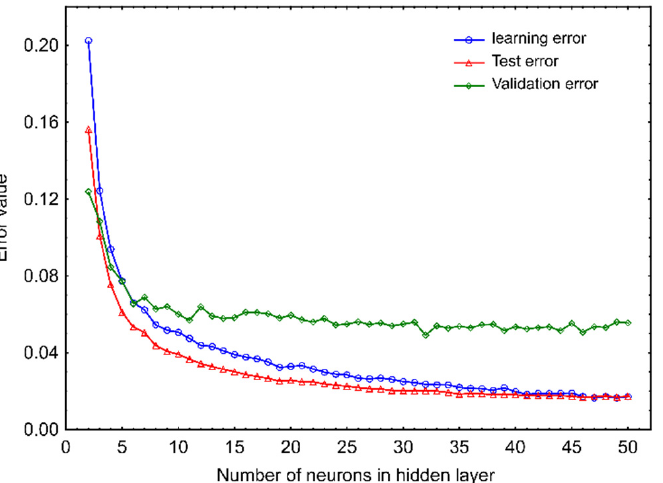
Figure 2. Changes in mean values of training, test and validation errors of RBF networks applied to modeling of phytosterol degradation depending on the number of neurons in the hidden layer equipped with an activation function in form of a gaussian function.